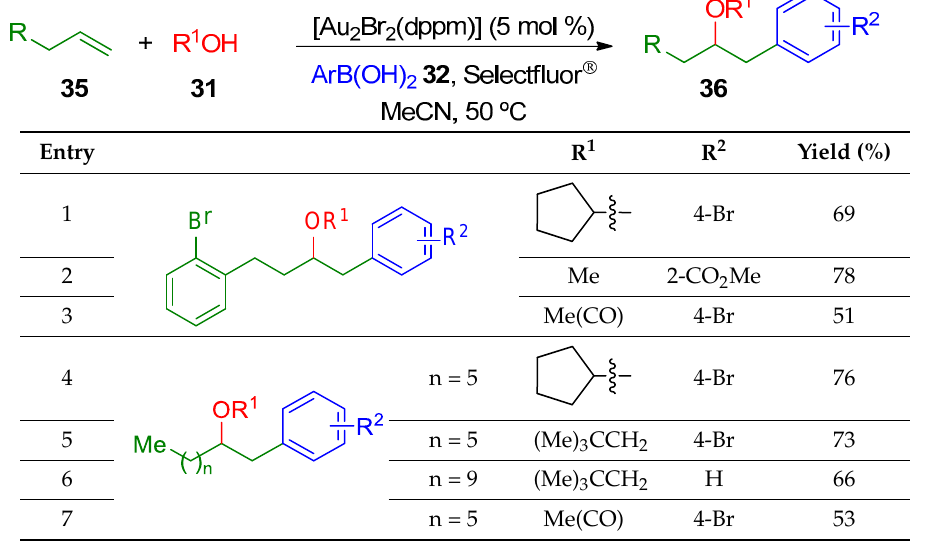
Table 3. Alkoxy- and acyloxyarylation of simple alkenes 35 .